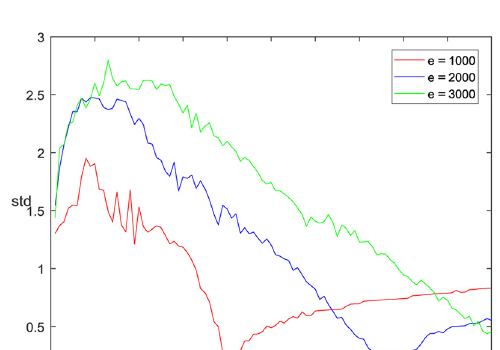
Figure 12. Commodity equilibrium price e = 3,000